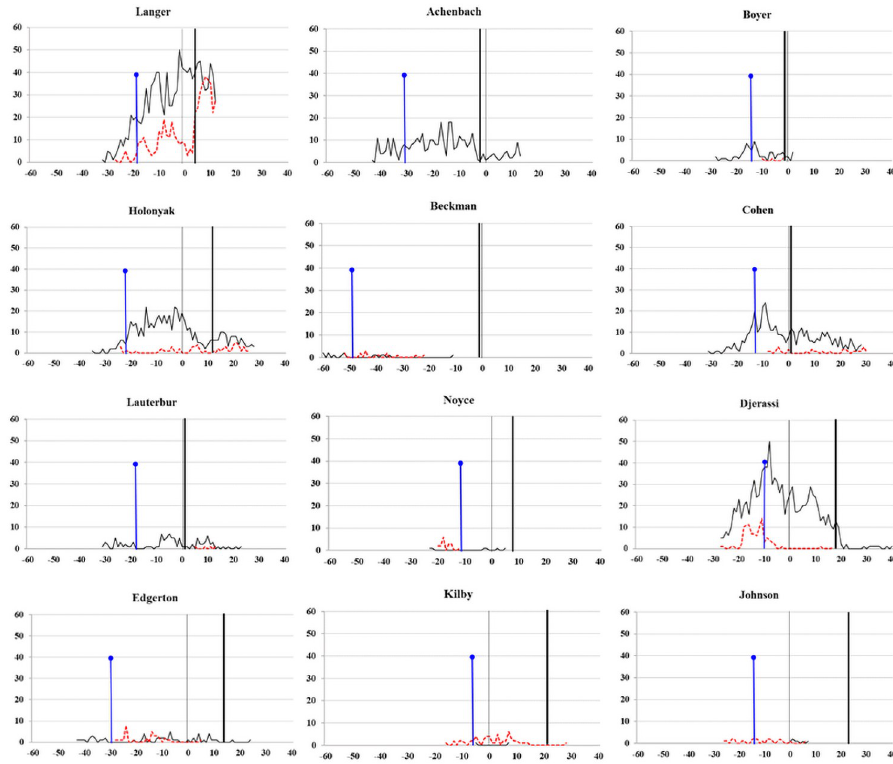
Fig 2. Numbers of articles and patents by year for individual